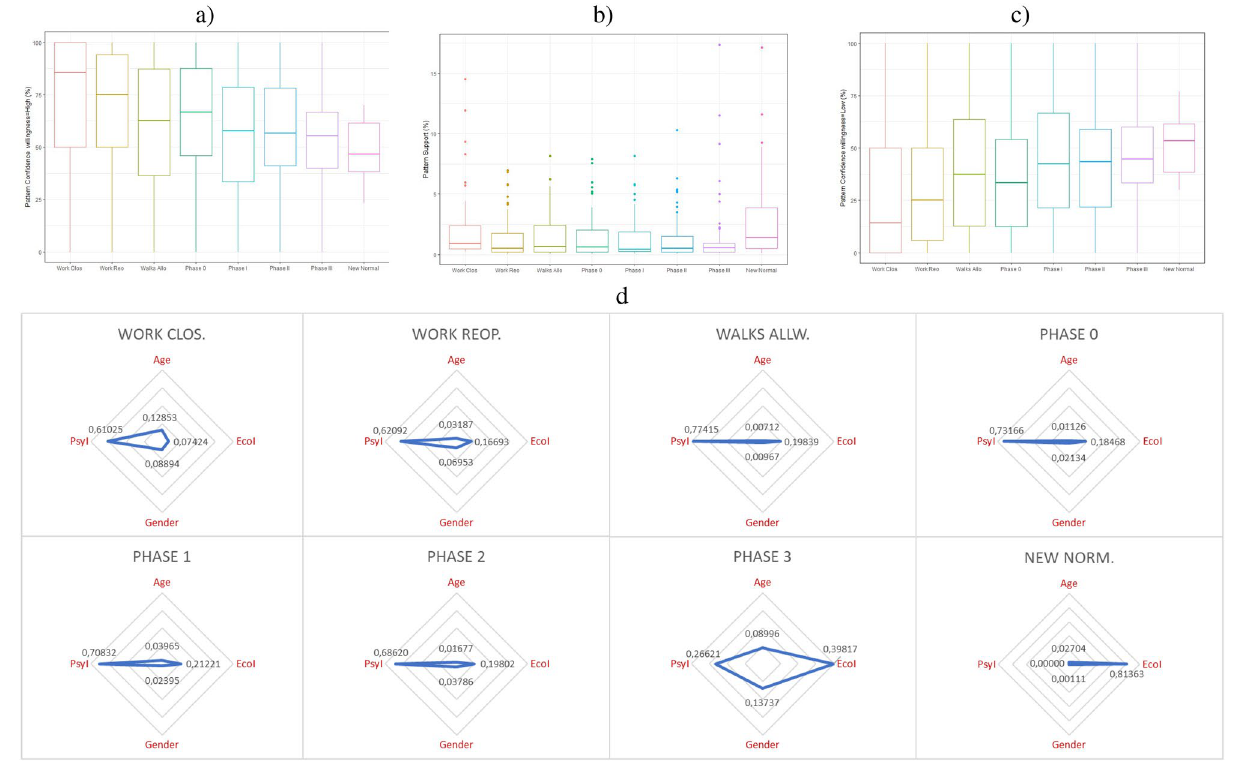
Figure 4. ( a ) Confidence statistics of the patterns in each phase for the willingness to be confined for 6 months or longer. ( b ) Support statistics of the identified patterns in each phase. ( c ) Confidence statistics of the patterns in each phase for the willingness to be confined for 0 days. ( d ) Weights of the most important variables according to our pattern detection method per confinement Phase.